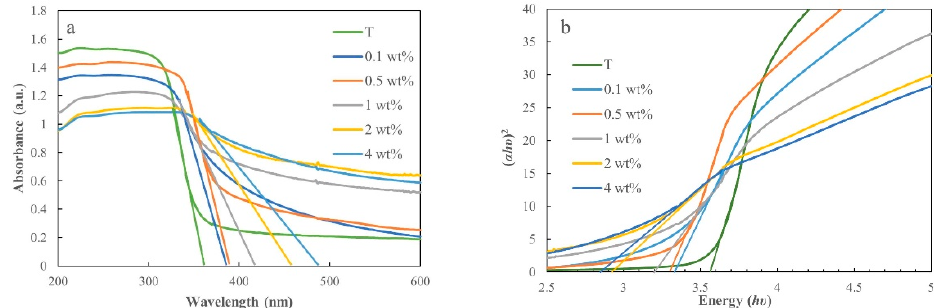
Figure 1. Optical properties of the pristine TiO 2 film (T) and TiO 2 -Ag composite films deposited using AgNO 3 concentrations of 0.1–4 wt%: ( a ) absorbance spectra, ( b ) plot of ( α h υ ) 2 versus photon energy ( h υ ). Table 1 . Bandgap energies ( E g ) of the films.